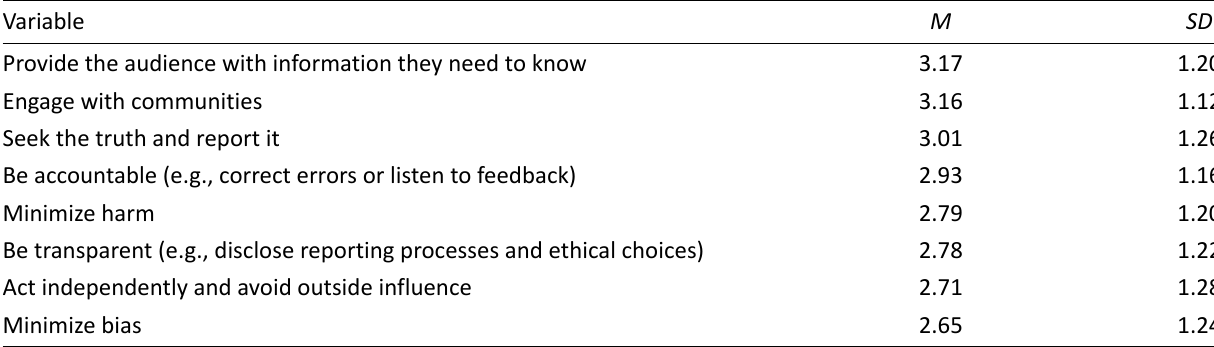
Table 3. Means of perception of media ethics by scale item. Variable